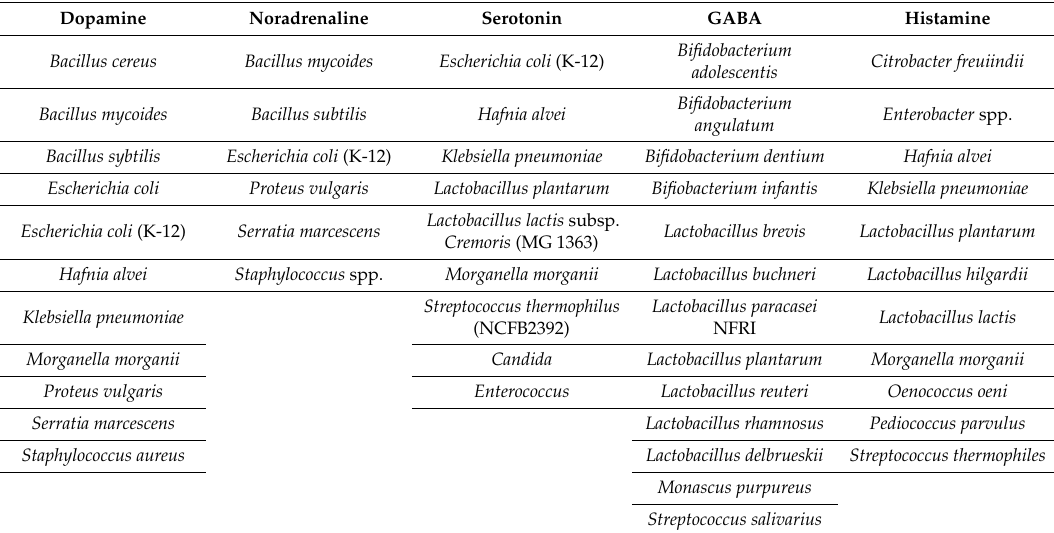
Genera and species with potential for neurotransmitter synthesis [39,64,65]. GABA—gamma–amino butyric